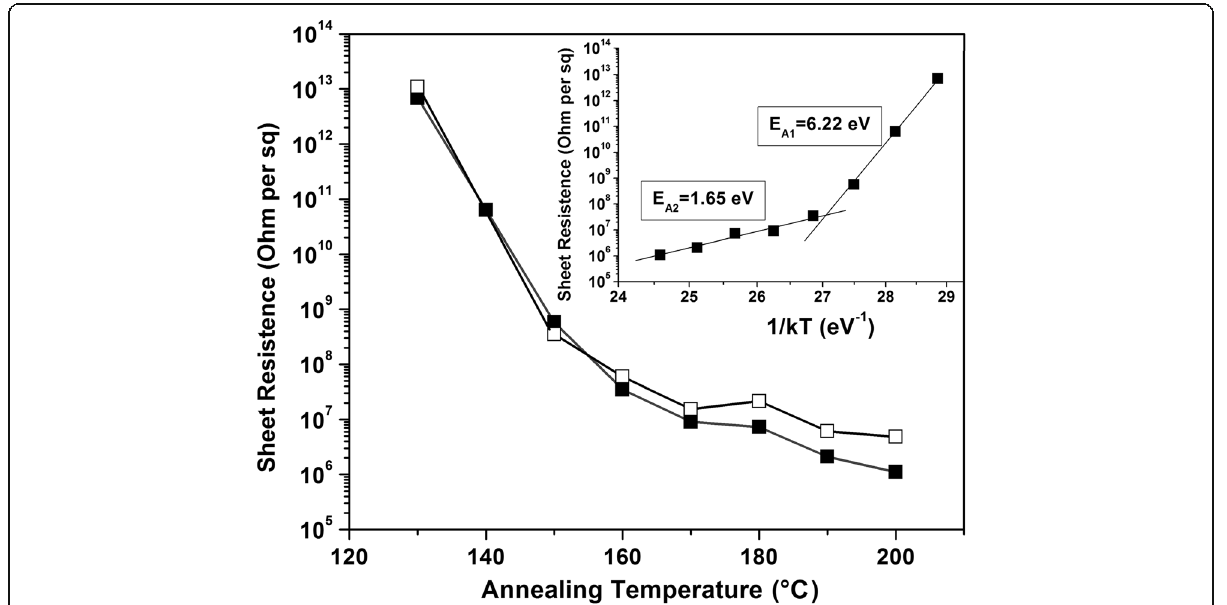
Fig. 5 Sheet resistivity measured by 4PP method vs. annealing temperature in air ambient. Inset: Arrhenius plot. Black squares — initial measurements, empty squares — measurements after 6